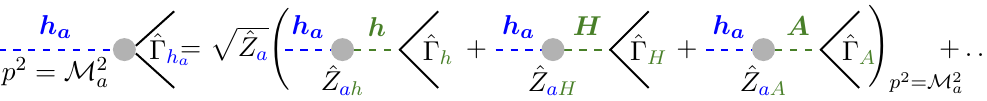
is constructed from vertex a p ^ Z a . The